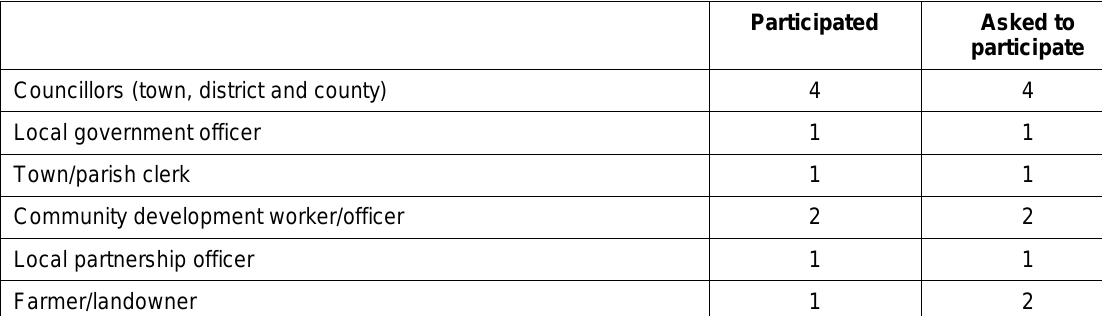
Table 2: Interviewees